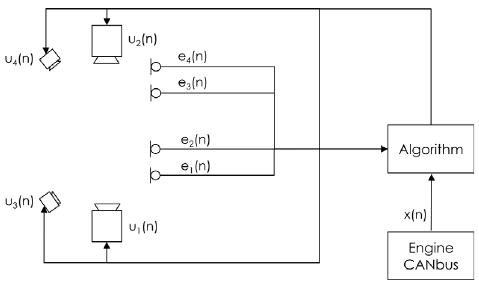
Figure 2. Block diagram of the ANC system highlighting the direction of the data fl ow in the control system.